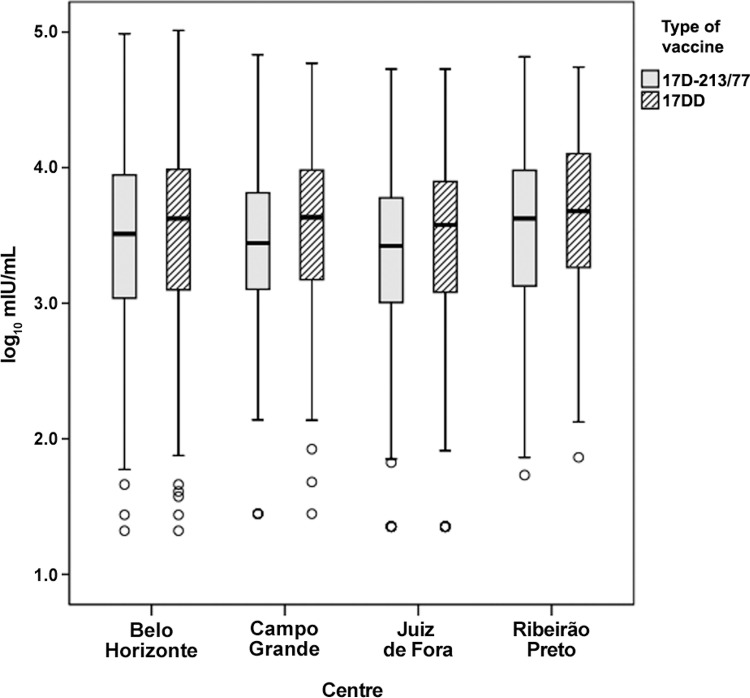
: medians and quartiles of the log10 of the antibody titres against yellow
fever 30 days or more after vaccination according to the type of vaccine and
collaborating centres.